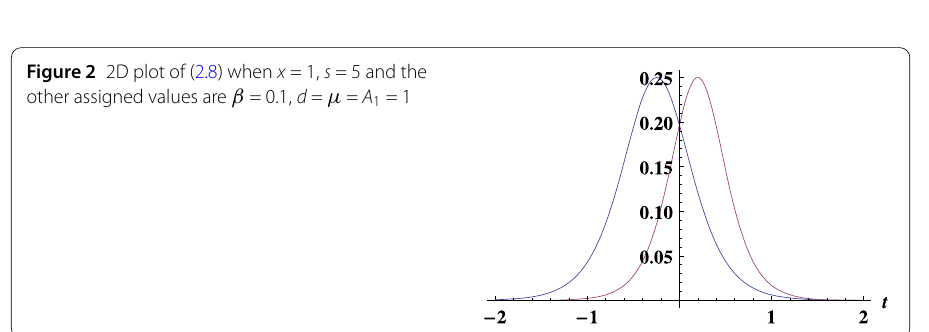
Figure 1 Shapes of the two-waves depicted in (2.8) by increasing the phase velocity: s = 1,3,5, respectively, and the other assigned values are β = 0.1, d = μ = A 1 = 1